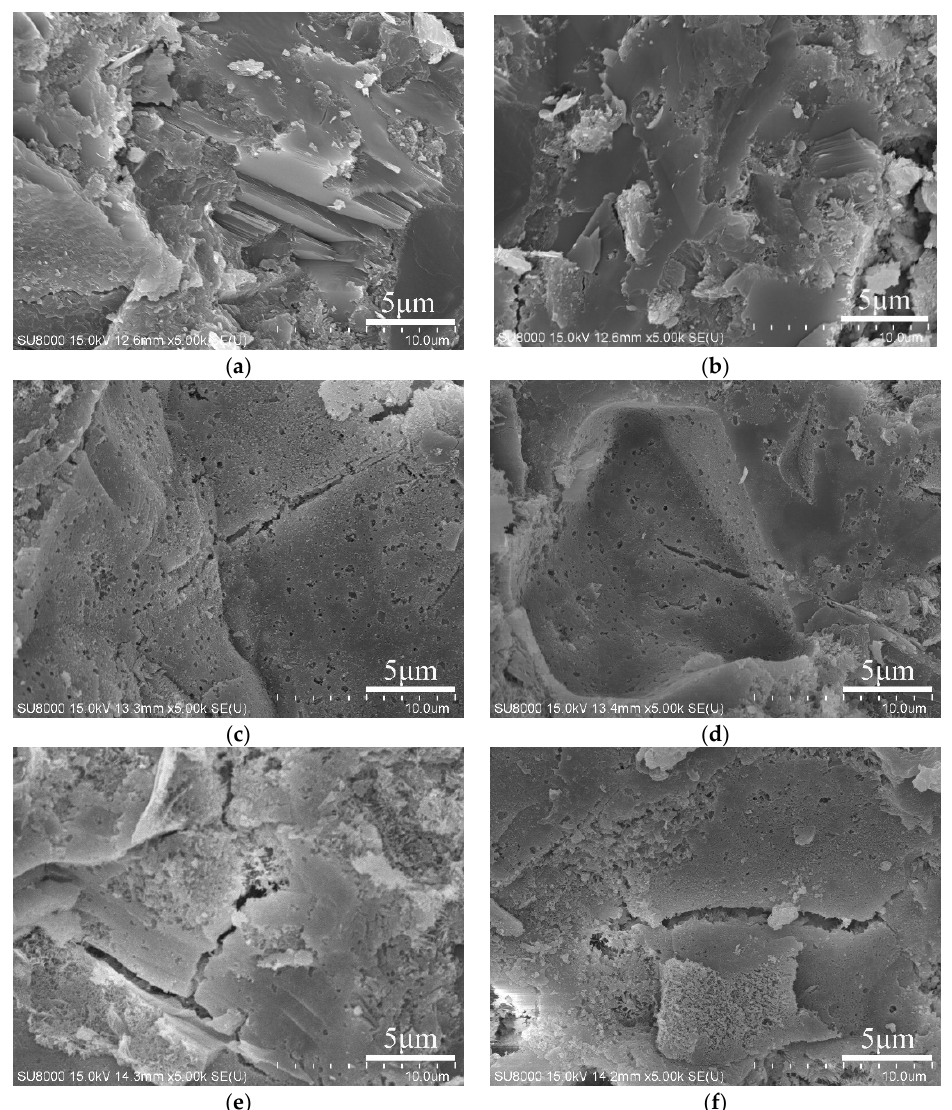
Figure 8. Micrographs of reference cement paste and 10% metakaolin-blended cement paste before and after 400 °C and 800 °C. ( a ) CP; ( b ) MK; ( c ) CP 400 °C; ( d ) MK 400 °C; ( e ) CP 800 °C; ( f ) MK 800 °C.